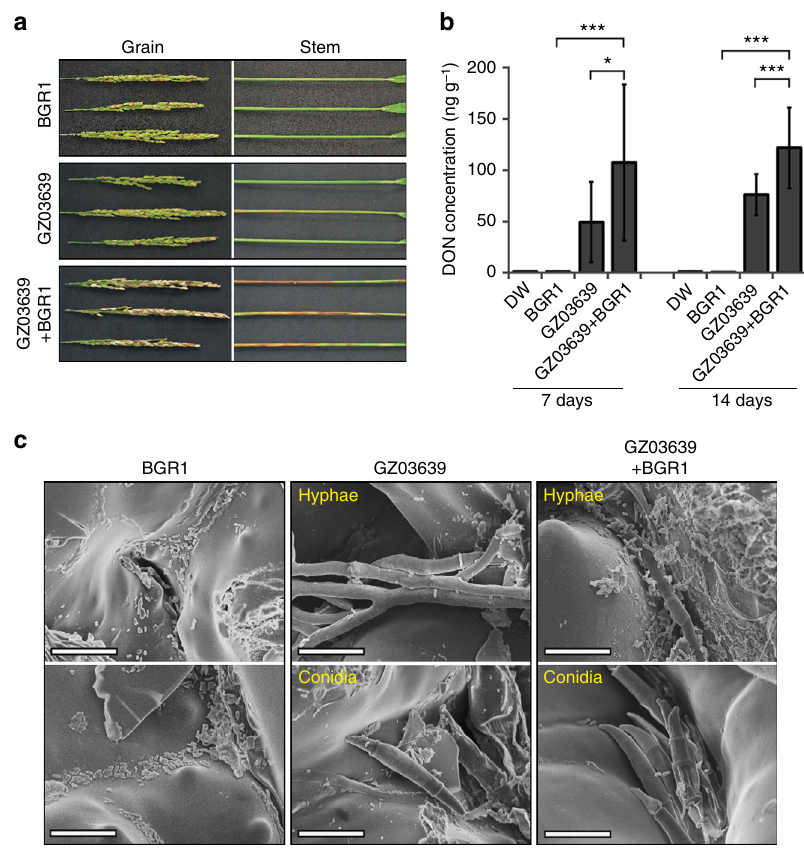
Fig. 6 Interactions between Bg and Fg on rice plants. a Disease severity of rice plants inoculated with either Bg, Fg or a combination of both. BGR1 and GZ03639 indicate single inoculations with Bg and Fg, respectively. GZ03639 + BGR1 indicates a co-inoculation of both pathogens. b DON was quanti fi ed in rice heads inoculated with either Bg, Fg, or a combination of both 7 d and 14 d after inoculation. The experiment was repeated twice with three replicates per sample and data presented are the mean ± s.d. (ANOVA; * P < 0.05, *** P < 0.001). c Images of Fg and Bg in rice husks as observed with a fi eld emission scanning electron microscope. Scale bar, 10 μ